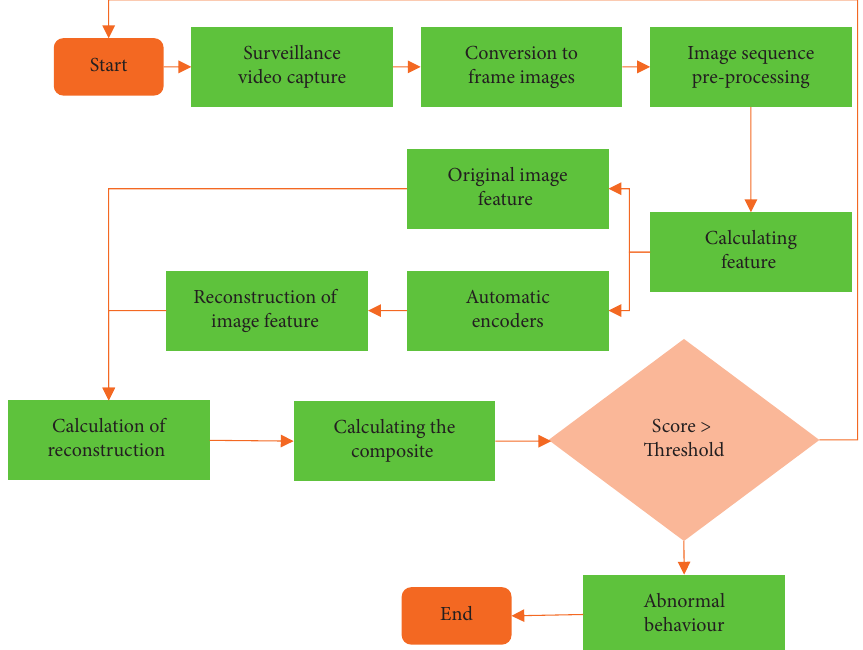
Figure 1: Flowchart of abnormal behavior detection.